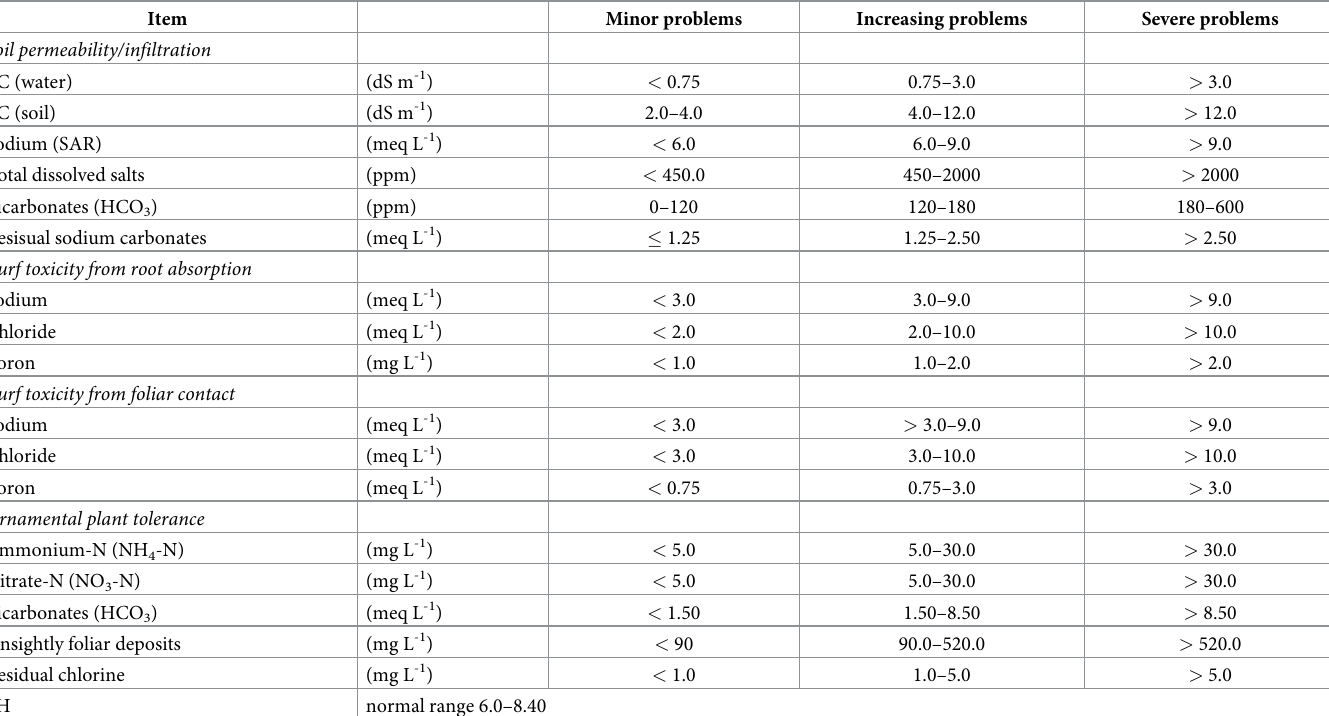
Table 6. General guidelines for interpretation of water quality for turfgrass irrigation (Ayers and Westcot, 1985, modified from McCarty, 2001). Minor problems Increasing